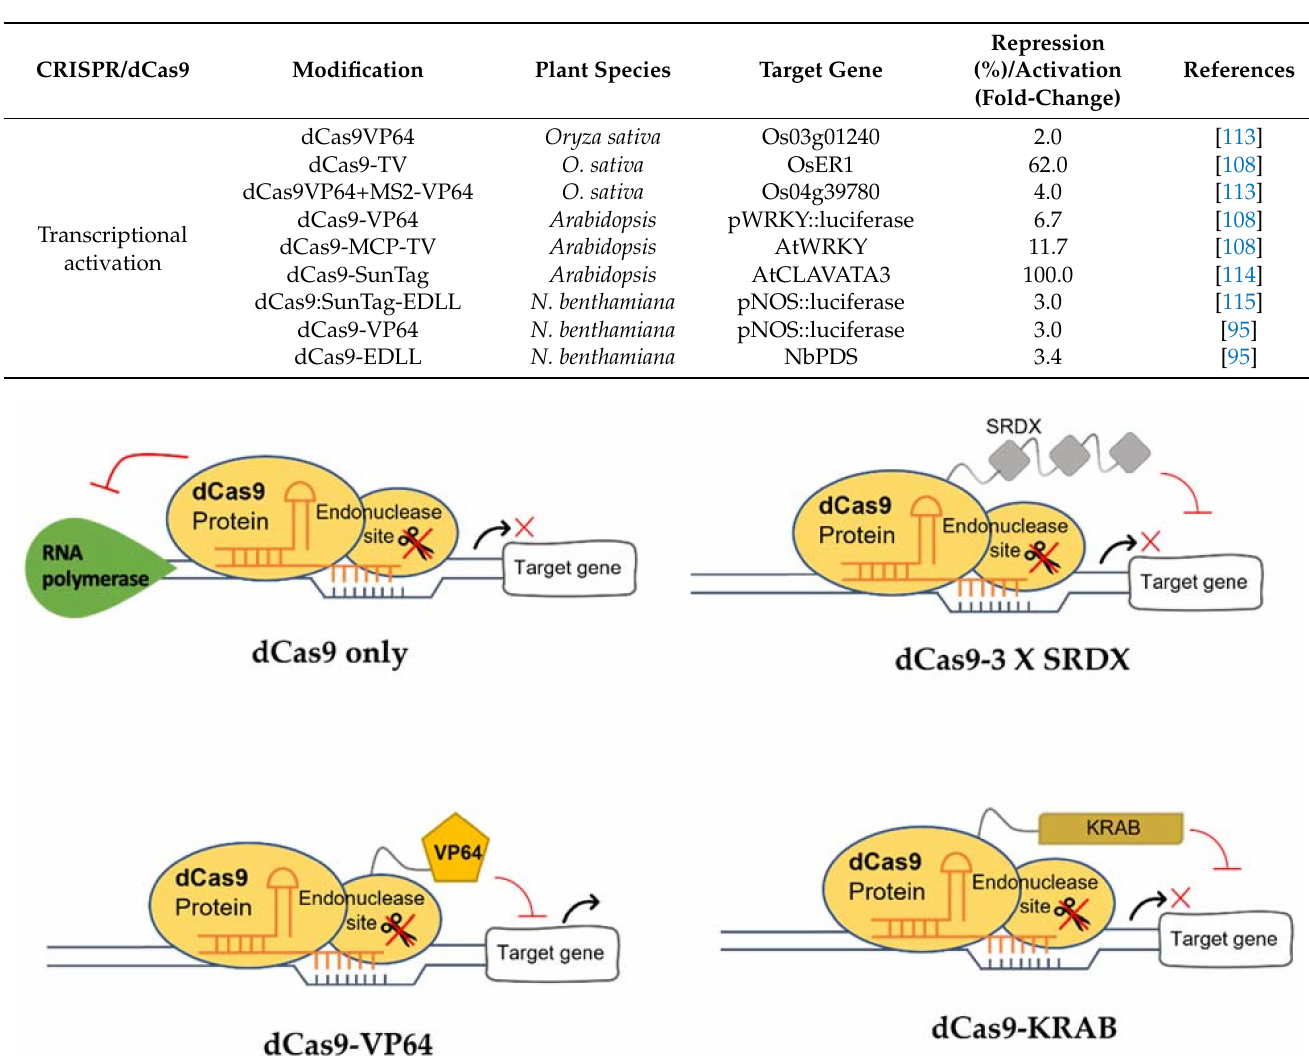
Figure 4. Different types of dCas9 protein with or without the effectors, such as KRAB and VP64. In CRISPRi, the binding of dCas9 at the target site of a gene prevents the transcription from initiating. Although dCas9 alone can interfere with the transcriptional machinery, its repression level is influenced by different repressors. A modified dCas9, dCas12a (also known as dCpf1), has been found to show better transcriptional repression compared to dCas9 [116]. dCas12a can process a single transcript tandem crRNA array to multi- ple crRNAs on its own, enabling a more simplified multiplex transcriptional repression compared to dCas9